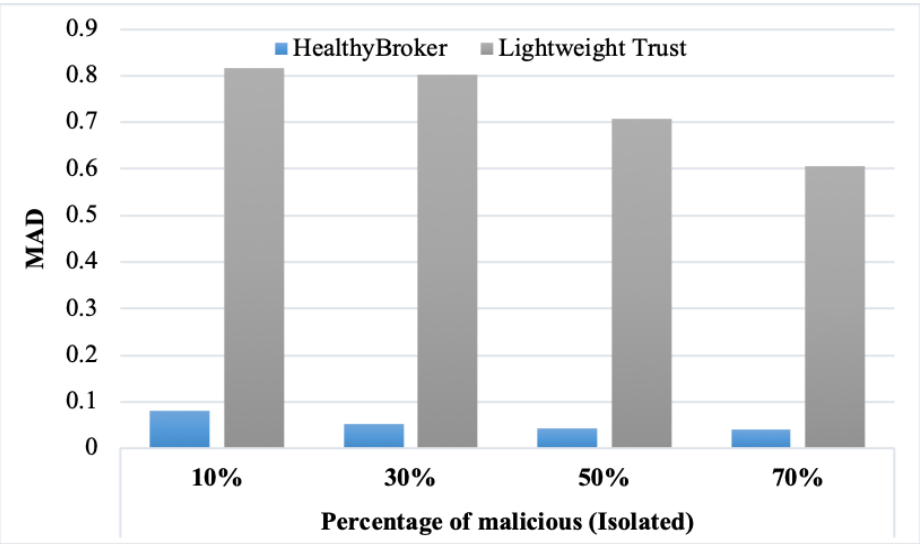
Figure 7. MAD result with feedback malicious